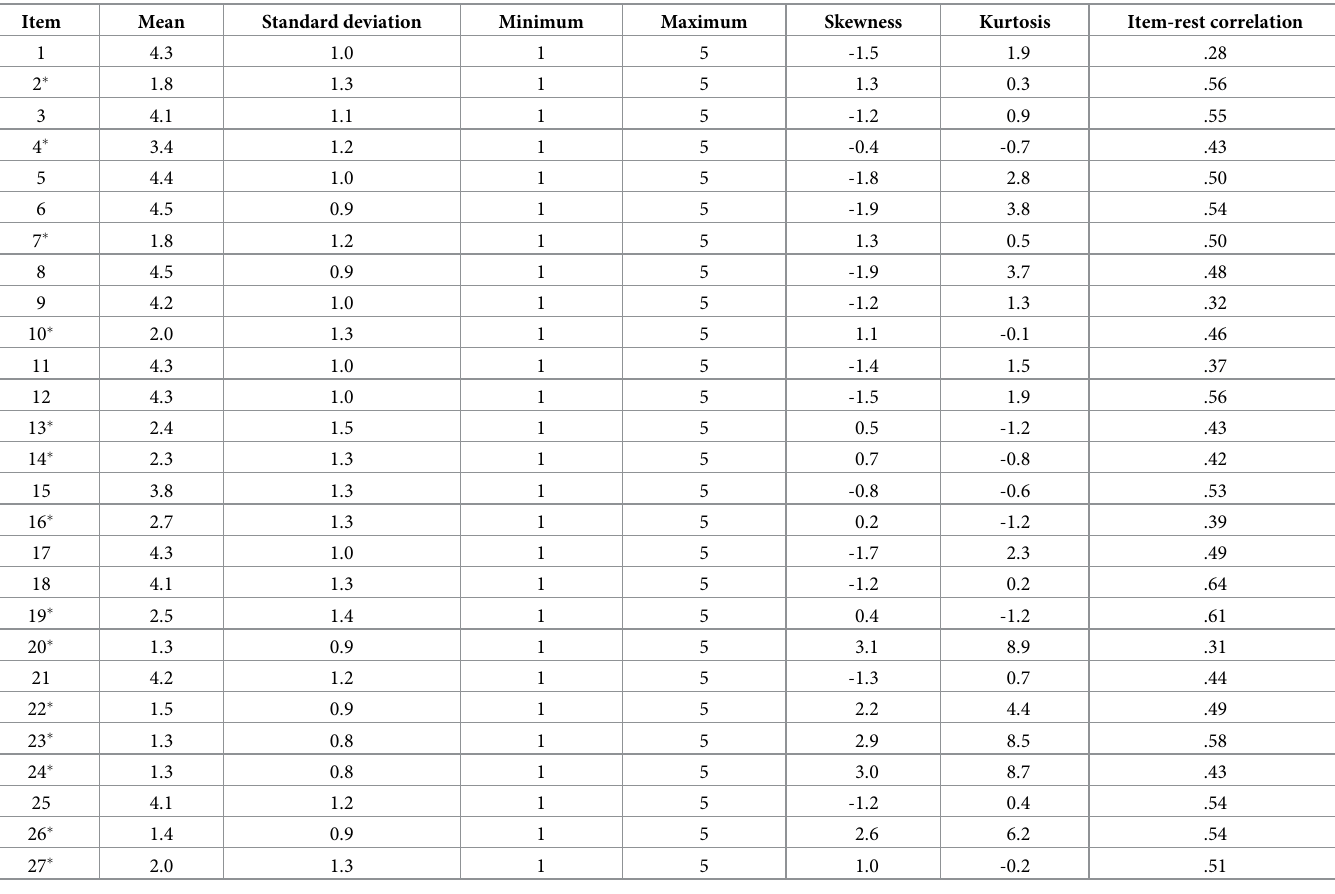
Table 2. Means, standard deviations, minimum scores, maximum scores, skewness, kurtosis and item-rest correlations in the COCOS